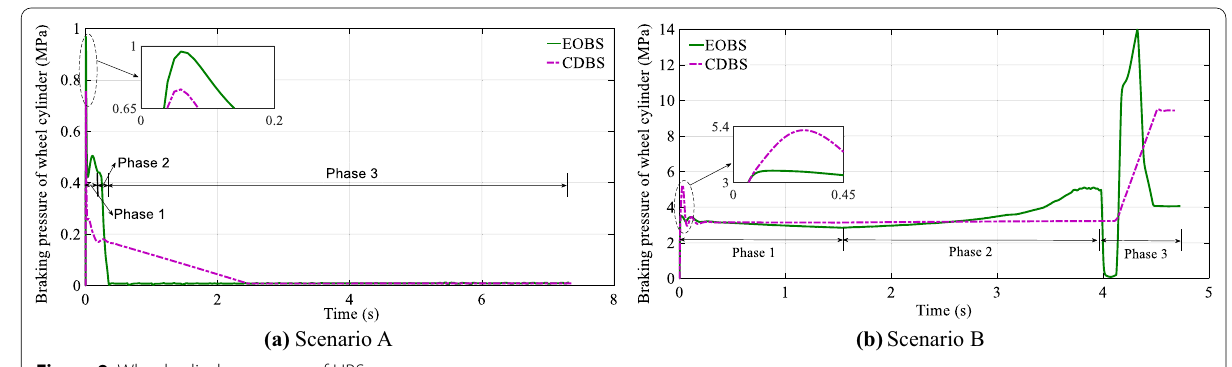
Figure 9 Wheel cylinder pressure of HBS